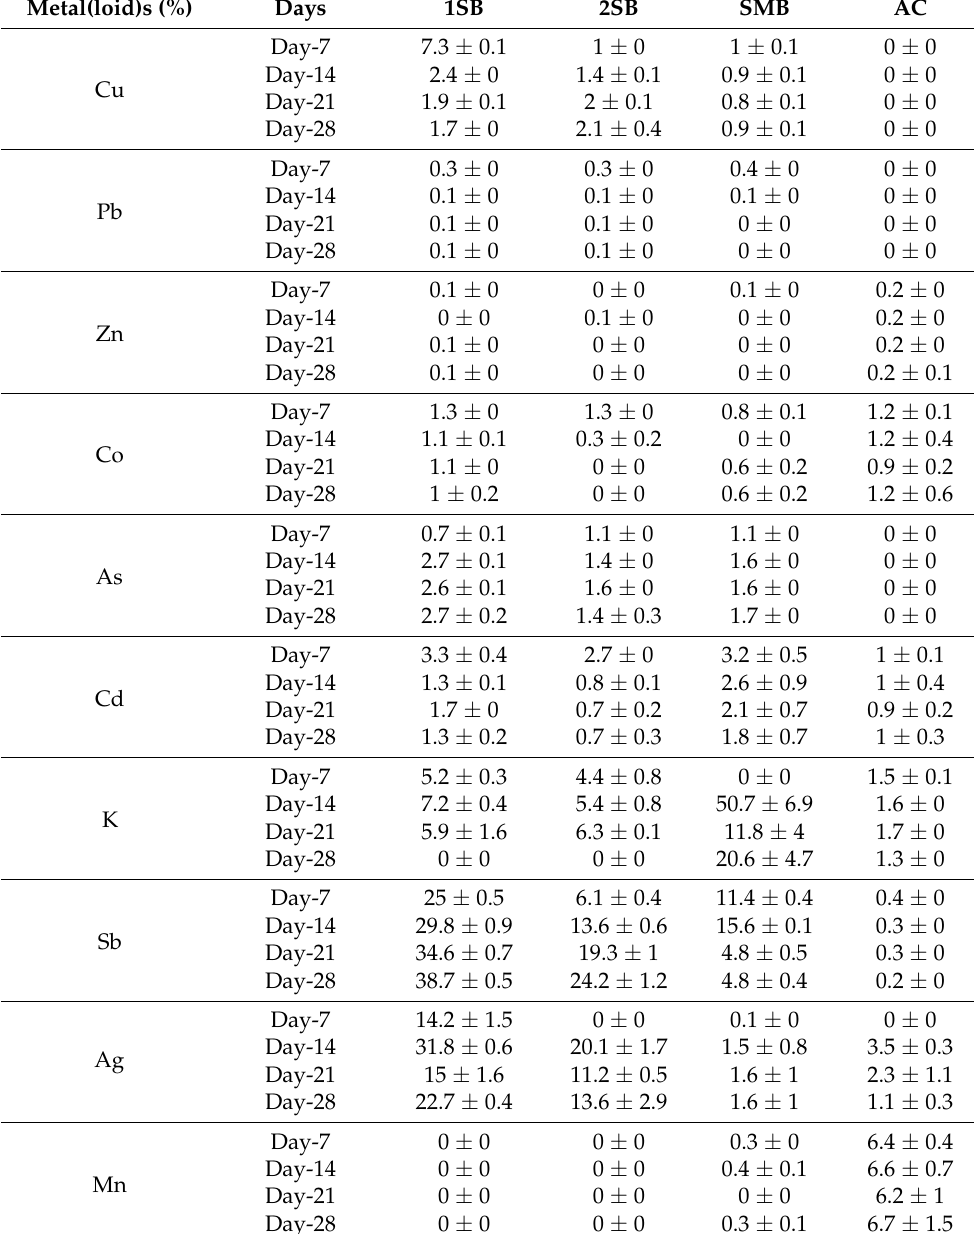
Table A2. Percentages of the metal(loid)s extracted from the Neves Corvo waste rock by T. thiocya- naticus via one-step bioleaching (1SB), two-step bioleaching (2SB), spent medium bioleaching (SMB), and the abiotic control (AC). Values are the average of duplicate flasks ± standard